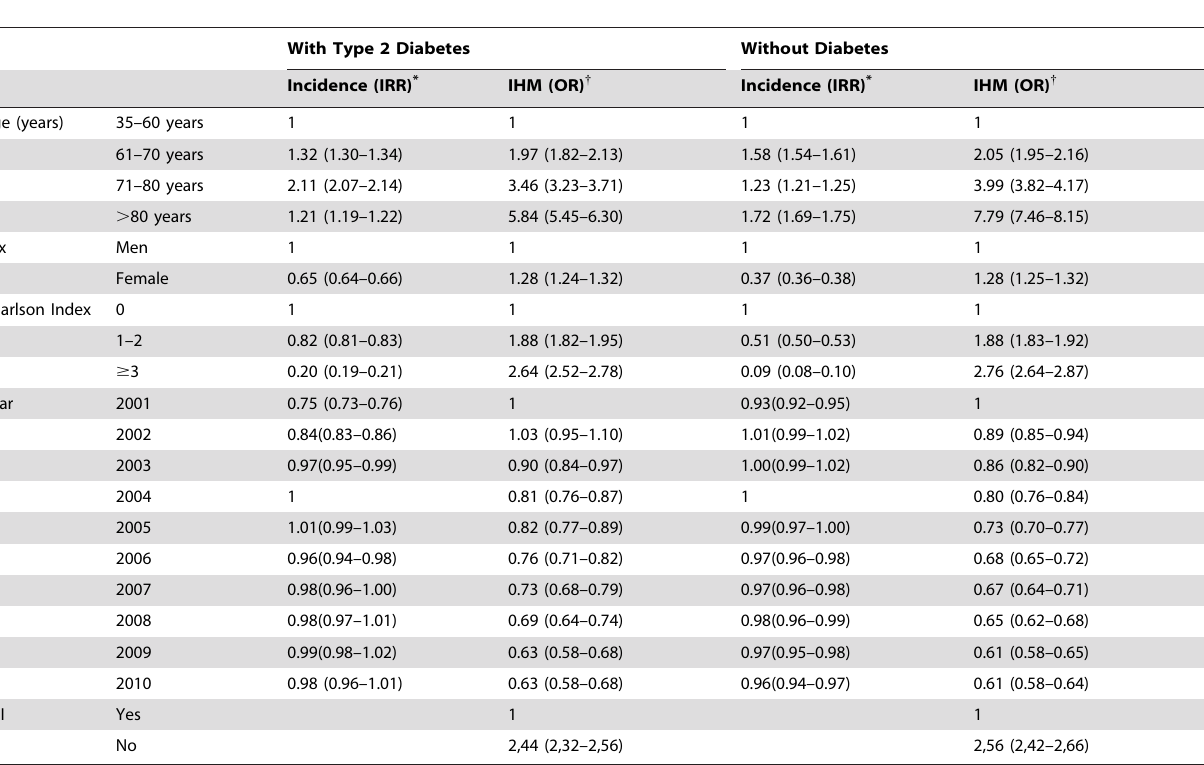
Table 2. Multivariate analysis of the factors associated with cumulative incidence and in-hospital mortality after acute myocardial infarction in patients with and without type 2 diabetes in Spain,